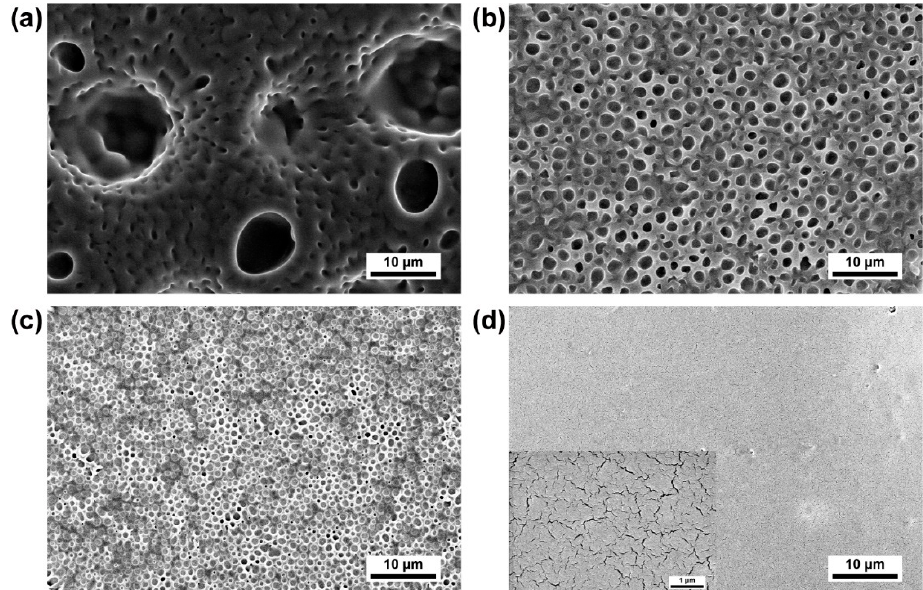
Figure 5. The polymer morphologies of samples B1–B4: ( a ) Sample B1; ( b ) Sample B2; ( c ) Sample B3; ( d ) Sample B4.